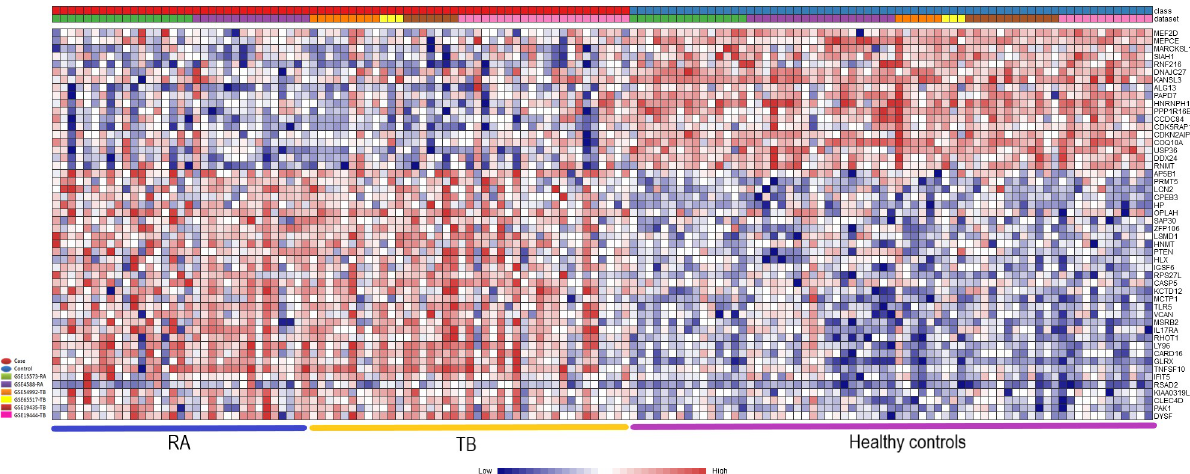
Fig 2. Heatmap of most significantly differentially expressed genes. Heatmap showing the relative expression of the 50 most significantly differentially expressed genes (DEGs) of the 341 significant DEGs identified through the meta-analysis, where 205 genes were co-up-regulated, and 136 genes were co-down-regulated (TB and RA versus control). The heatmap indicates the normalized expression value of each DEG in the individual samples, and genes were clustered based on their condition (cases vs controls) and their original datasets. The heatmap was created by the visualization module in NetworkAnalyst, and genes with p-value < 0.01 in the Random Effect Model analysis were considered significant.